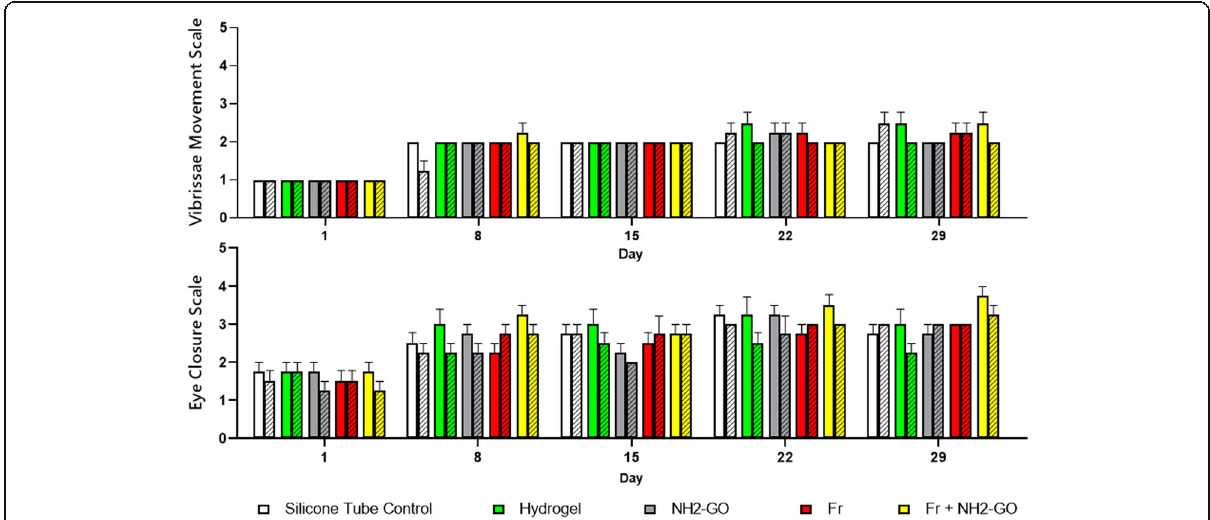
Fig. 6 Comparative graph of behavioral test results. Clear and shaded bars represent the scores of the left and the right side of the face, respectively. Error bars represent SEM. The data were analyzed with two-way ANOVA with Tukey multiple comparison test used for p value output. No statistically significant changes were reported between